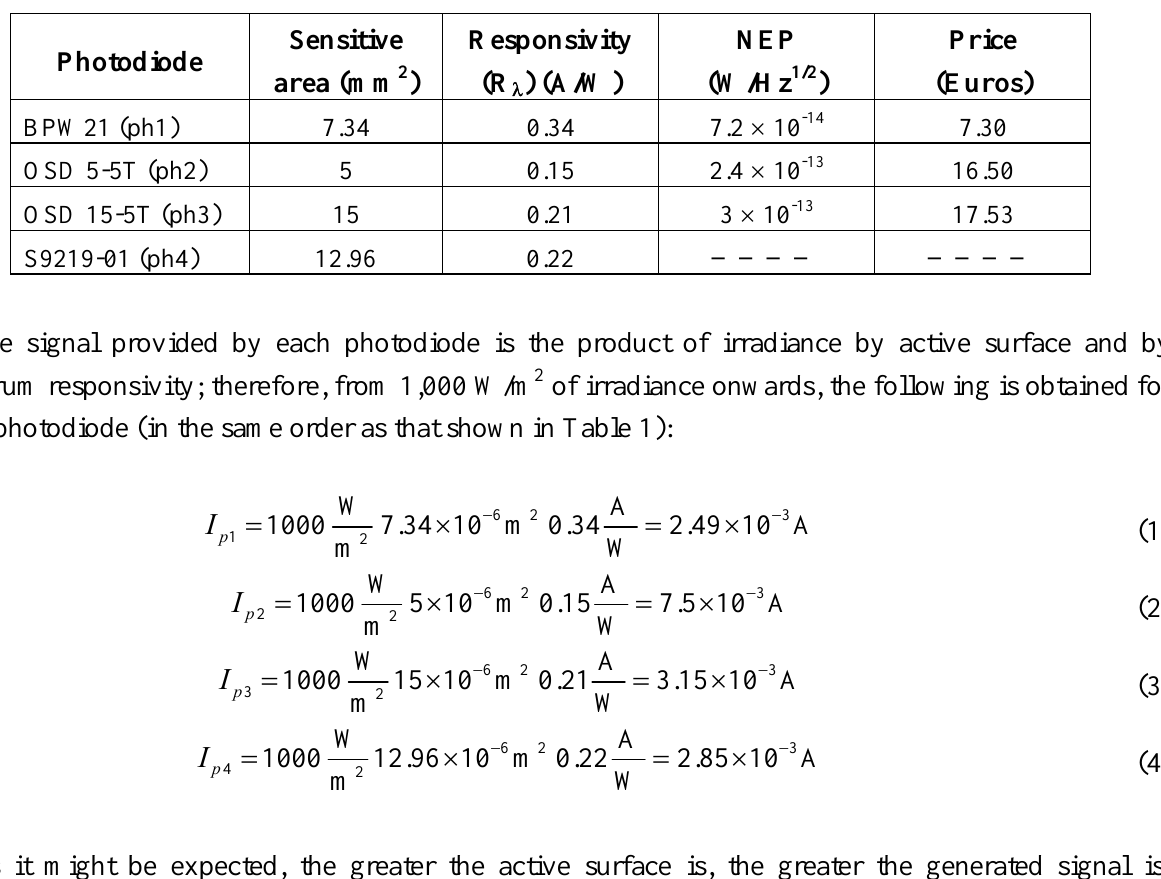
Table 1. Features of selected